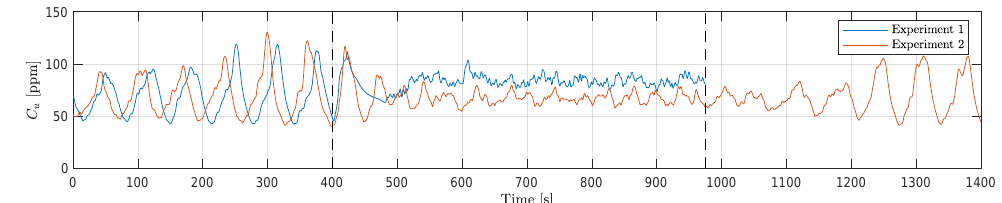
Figure 10. Underflow OiW concentration during both